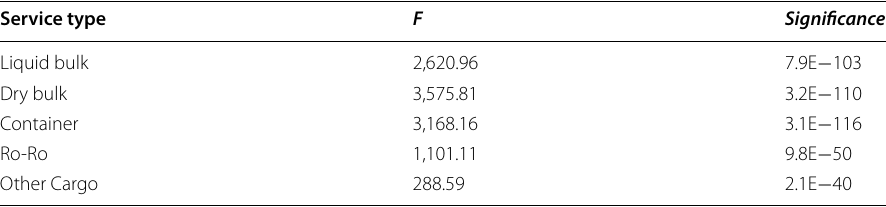
Table 7 Analysis of variance-Statistics